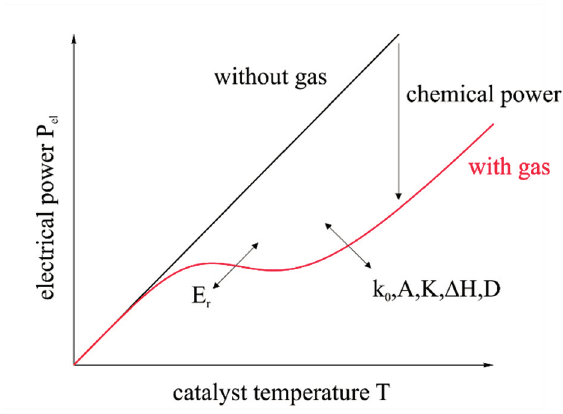
Figure 4. Schematic of the electrical power related to the catalyst temperature. The scheme shows a white range curve. Real measurements maximal run until point of inflection, since further behavior shows high temperatures. Technical implementation is not possible due to various reasons, e.g., catalyst